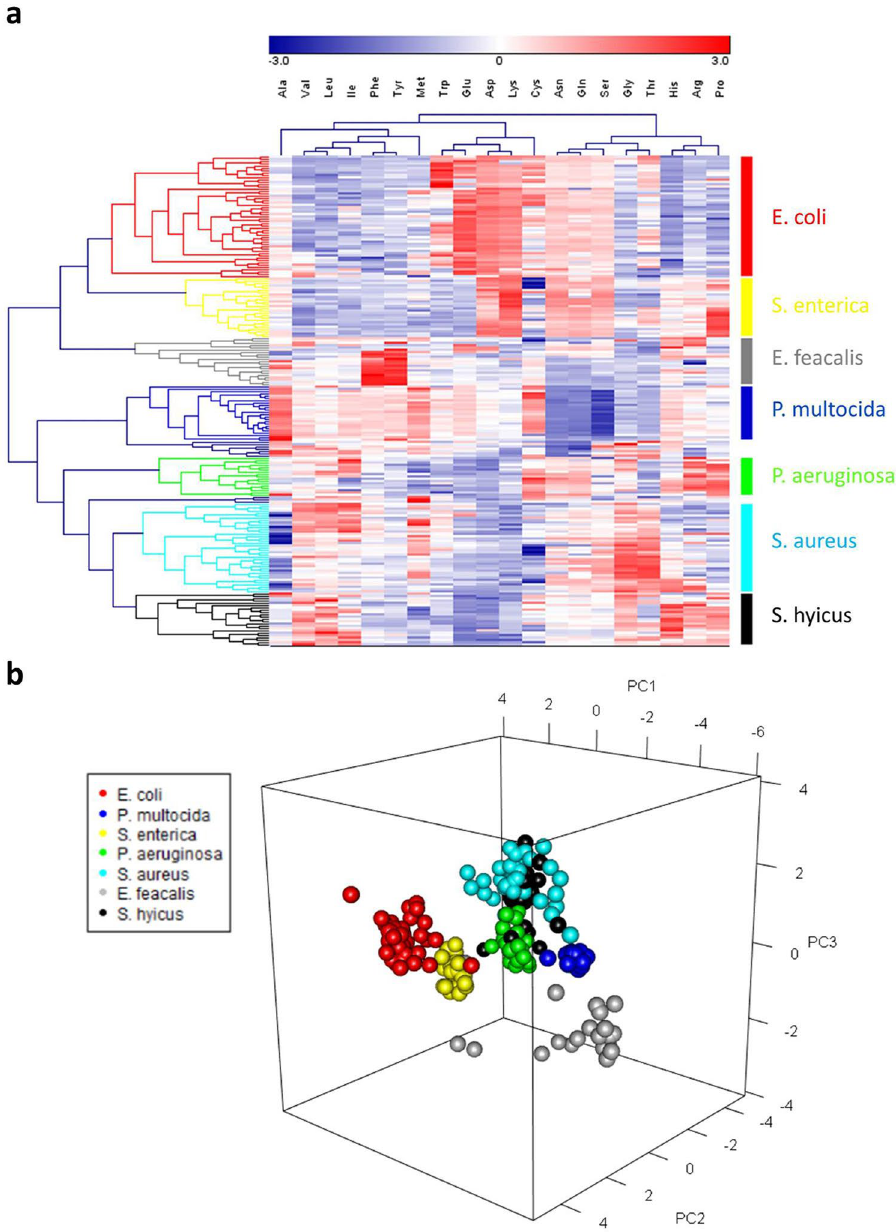
Figure 2. Clustering of bacterial strains by AA consumption profiles. ( a ) Hierarchical clustering and heat map of differentially consumed AAs in 213 strains. The clusters represent seven bacterial species are evident. Red represents high relative consumption and green represents low relative consumption as shown in colored scale bar above the heat map. ( b ) 3-D view of principal component analysis of 213 bacterial strains. Each spot colored according to different species indicates individual